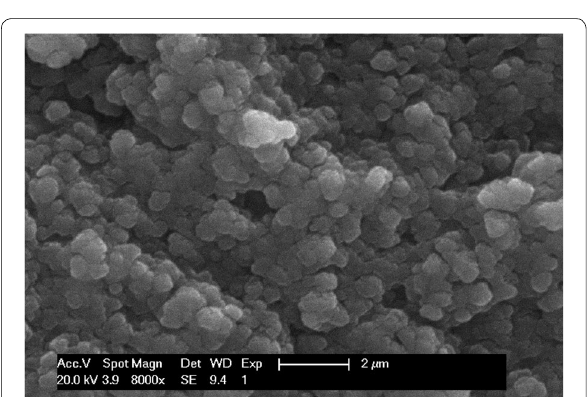
Fig. 8 Outer layer of unburned particles in M-FA(HCC)-1.